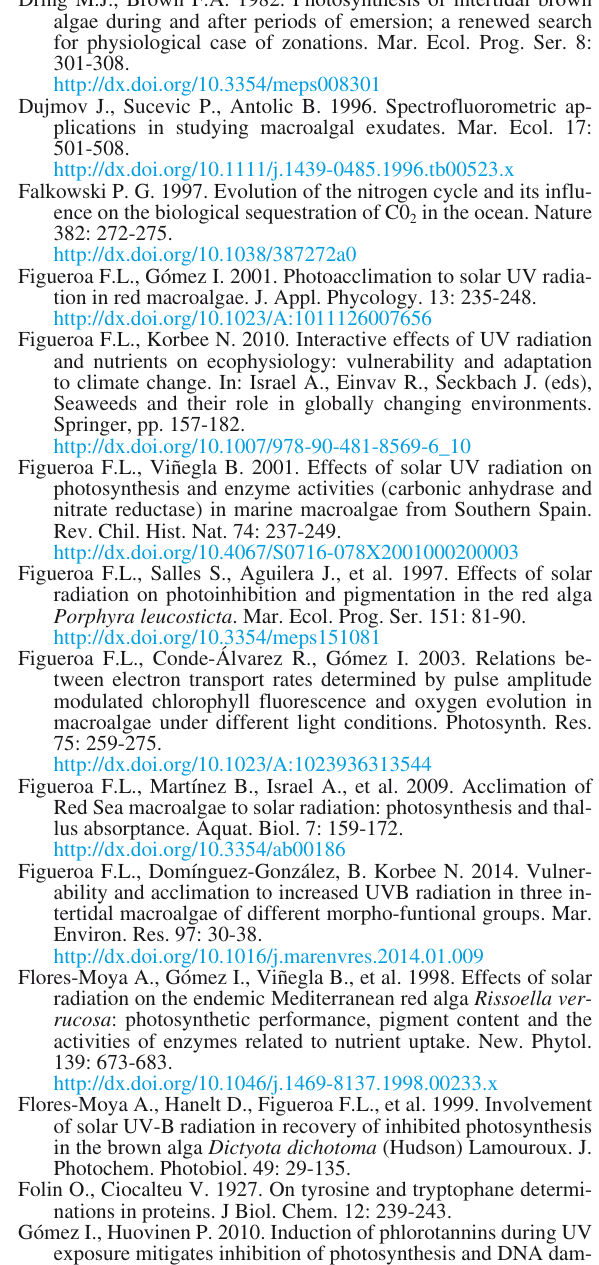
by PAM fluorescence. Aquat. Bot. 61: 225-236. http://dx.doi.org/10.1016/S0304-3770(98)00068-0 Hanelt D. 1996. Photoinhibition of photosynthesis in marine mac- roalgae. Sci. Mar. 60: 243-248. Hanelt D., Figueroa F.L. 2012. Physiological and photomorphogenic effects of light of marine macrophytes. In: Wienke C.,